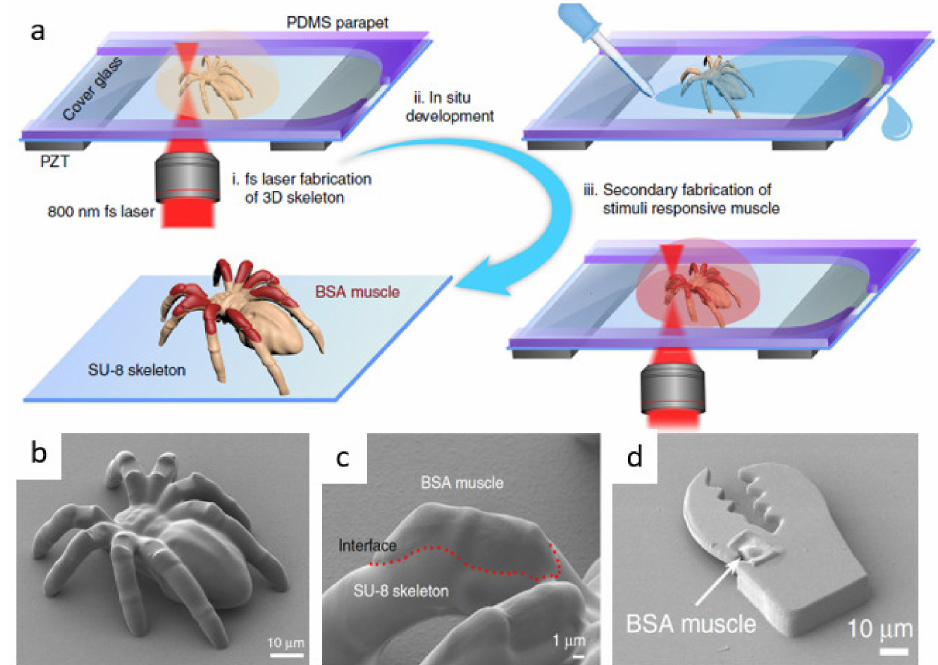
Figure 8. SU-8/BSA micro-robots fabricated by MPL. ( a ) Multi-material MPL scheme where the SU-8 skeleton is fabricated and developed in situ using a PDMS parapet, and fabrication is resumed after the addition of BSA. ( b ) SEM image of dynamic spider fabricated by MPL. ( c ) Magnified image showing the SU-8/BSA interface. ( d ) SEM image a claw micro-gripper actuated with pH stimulus. Figure reproduced with the permission of the authors from Ref. [88] licensed under CC BY